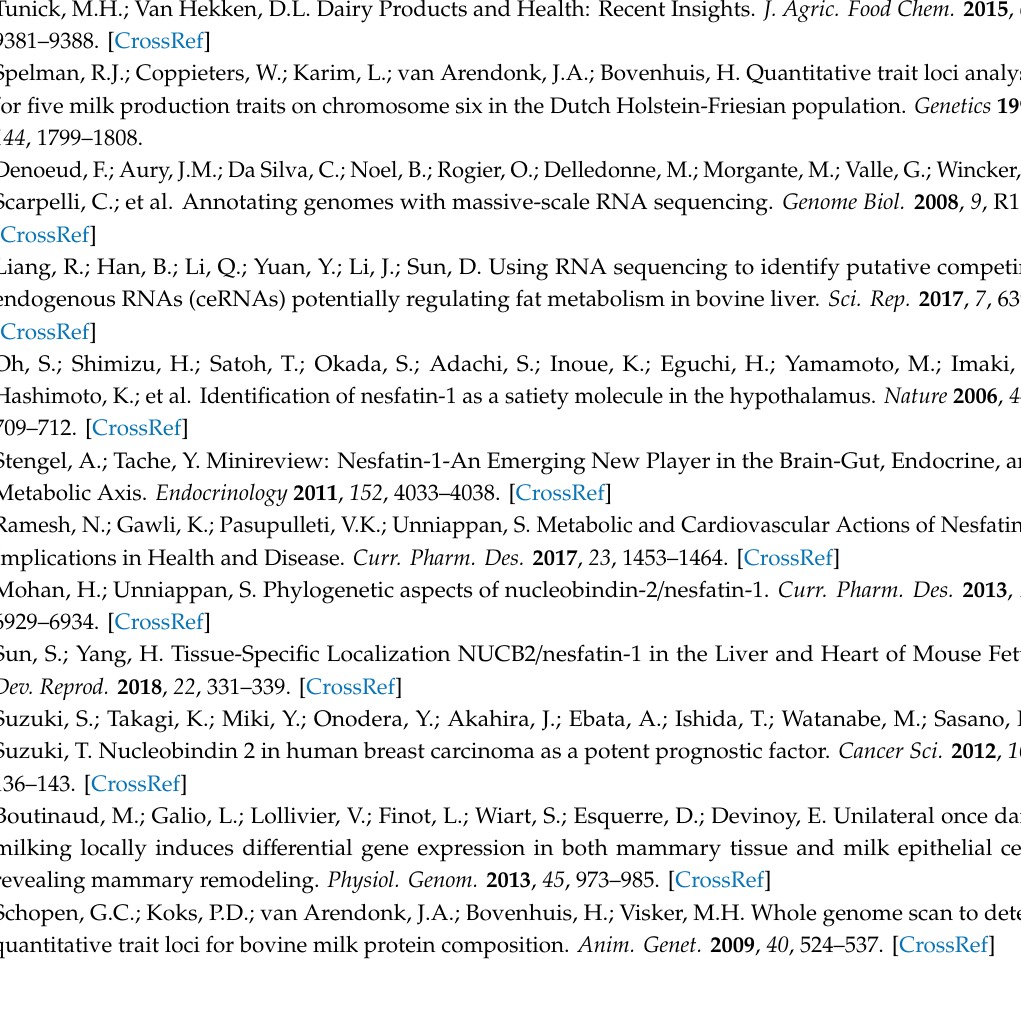
Table S1: Descriptive statistics of the phenotypic values for milk production traits. Table S2: Primers and procedures for PCR and qPCR used in SNP identification. Table S3: Additive, dominant and allele substitution e ff ects of SNPs on milk production traits in Chinese